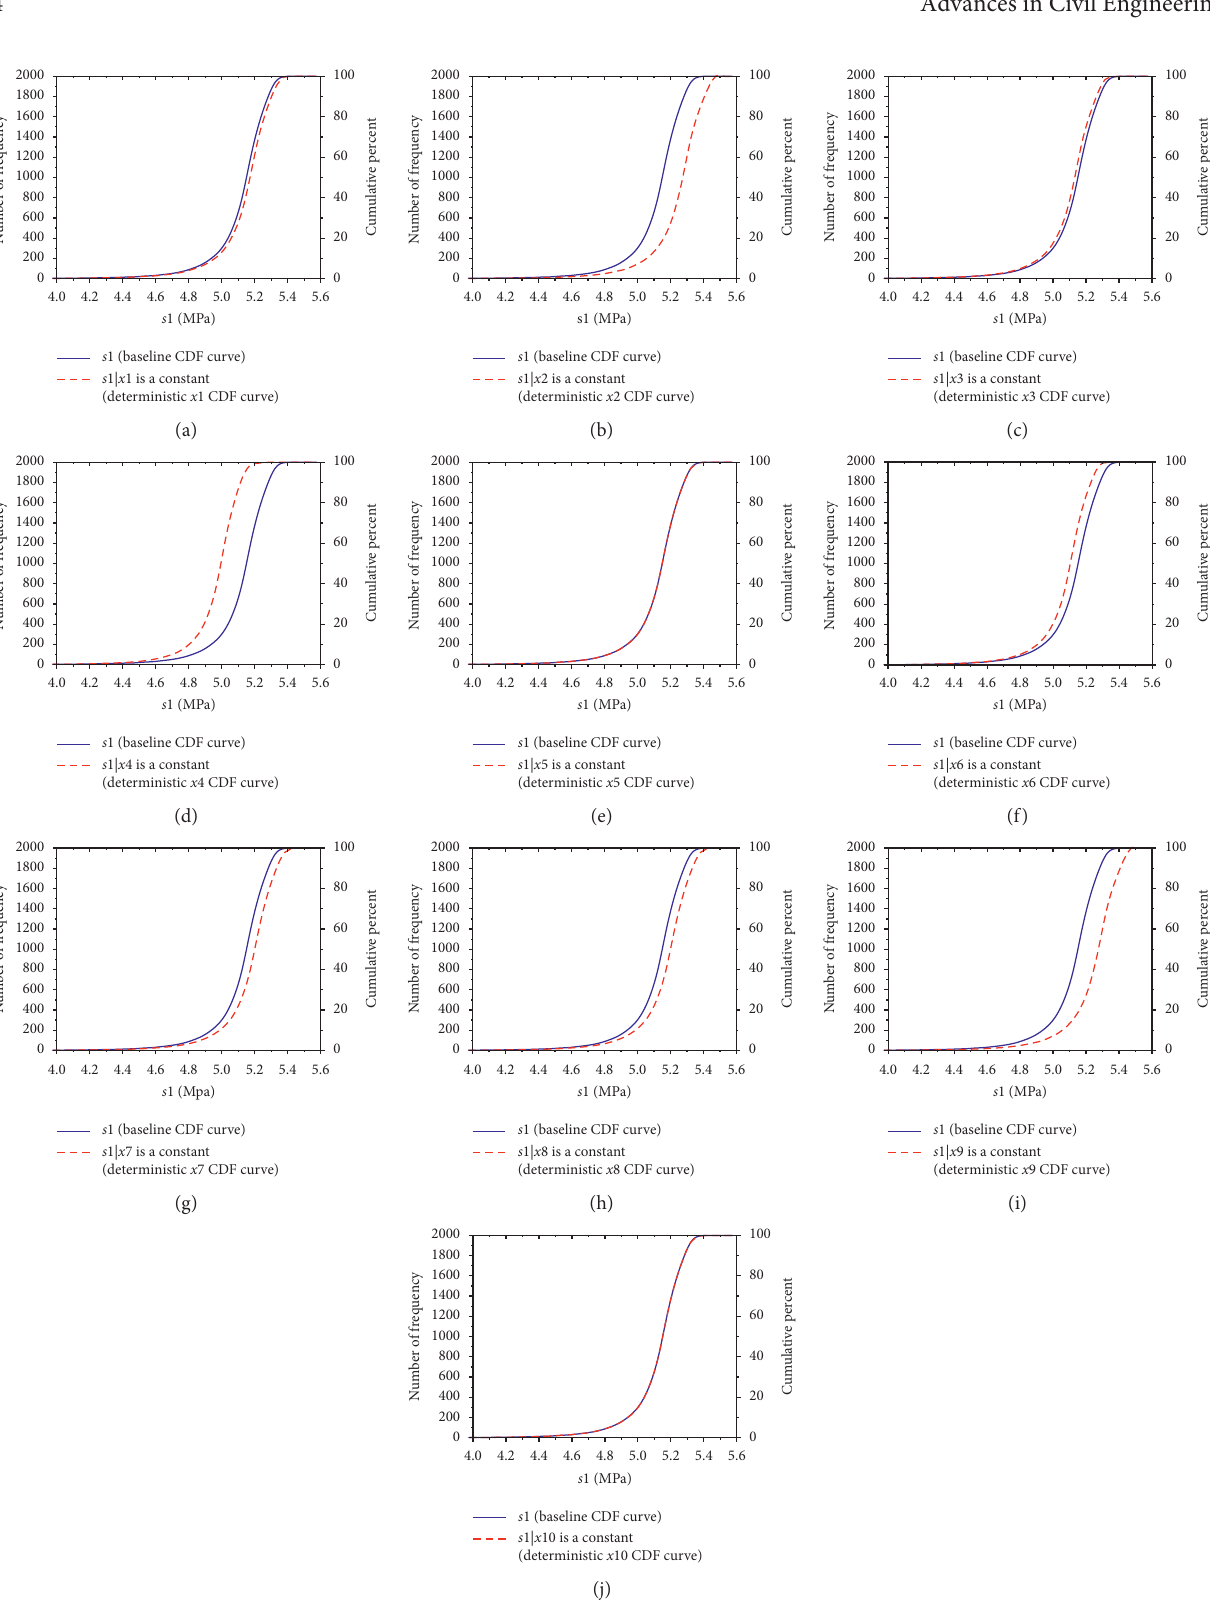
Figure 8: Comparison of single-deterministic-parameter CDF curves and baseline CDF curves for the model output s1 ( average bubble chamber pressure per ring